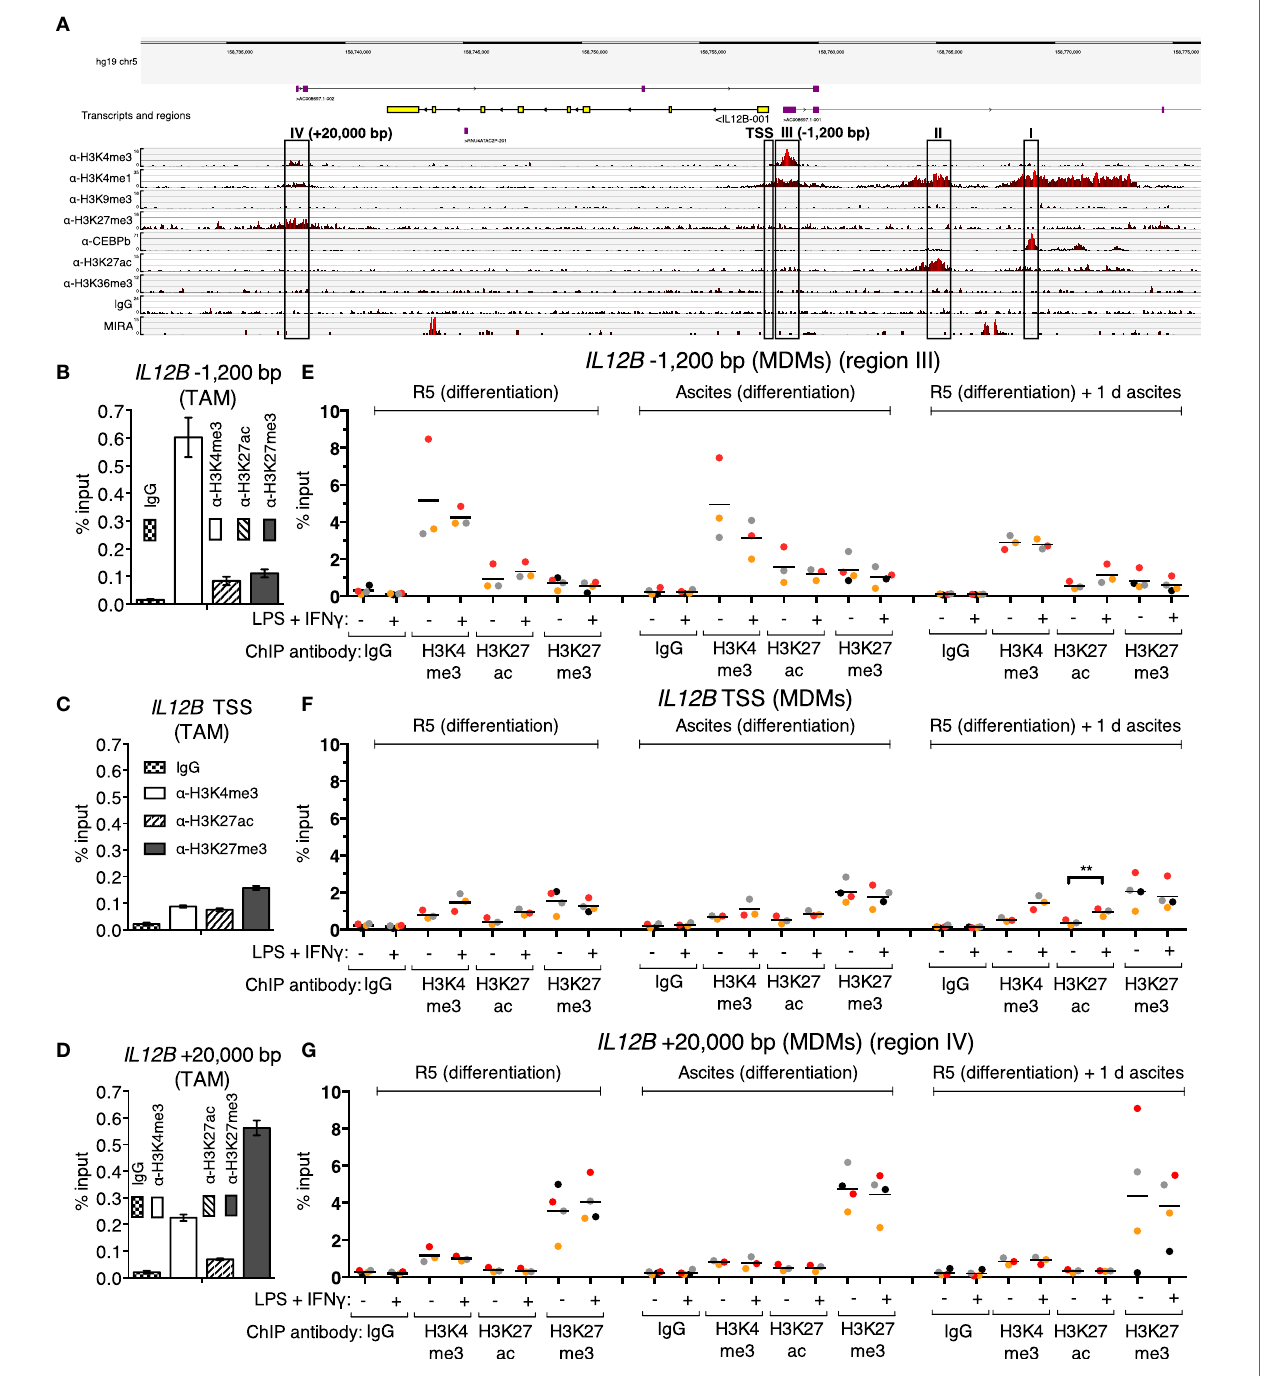
FigUre 4 | Chromatin marks at the IL12B locus. (a) A genome browser snapshot, including ChIP-seq tracks for α -H3K4me3, α -H3K4me1, α -H3K9me3, α -H3K27me3, α -C/EBP β , α -H3K27ac, α -H3K36me3, IgG (unspecific polyclonal rabbit IgG pool) chromatin immunoprecipitations, and MIRA from a TAM sample freshly isolated from ovarian carcinoma ascites. Regions of interest are highlighted by rectangles. (B–D) ChIP-qPCR analyses of the indicated histone marks in an independent TAM sample at the indicated genomic locations amplified by specific primers are indicated. The error bars denote SDs from technical PCR replicates. (e–g) ChIP-qPCR analyses of the indicated histone marks in MDMs from three different pooled donor populations ( N = 3; N = 4 for IgG and α -H3K27me3 samples) differentiated in normal medium, in ascites, or in normal medium followed by ascites for 1 day. Cells were stimulated with or without LPS and IFN γ ( + ) or their respective solvents ( − ) 2.5 h prior to harvesting. Genomic regions were amplified by specific primers are indicated. Each dot denotes a biological replicate; for each replicate, MDMs from six donors were pooled after harvesting of the cells for each experiment. Median values are indicated by horizontal bars. Colors encode ascites samples from individual patients, and colors are consistent between panels within this figure, Figure 5 and Figure S9 in Supplementary Material. Statistical significances were calculated with paired t -tests. ** P < 0.01; all other analyses did not show significance ( P >